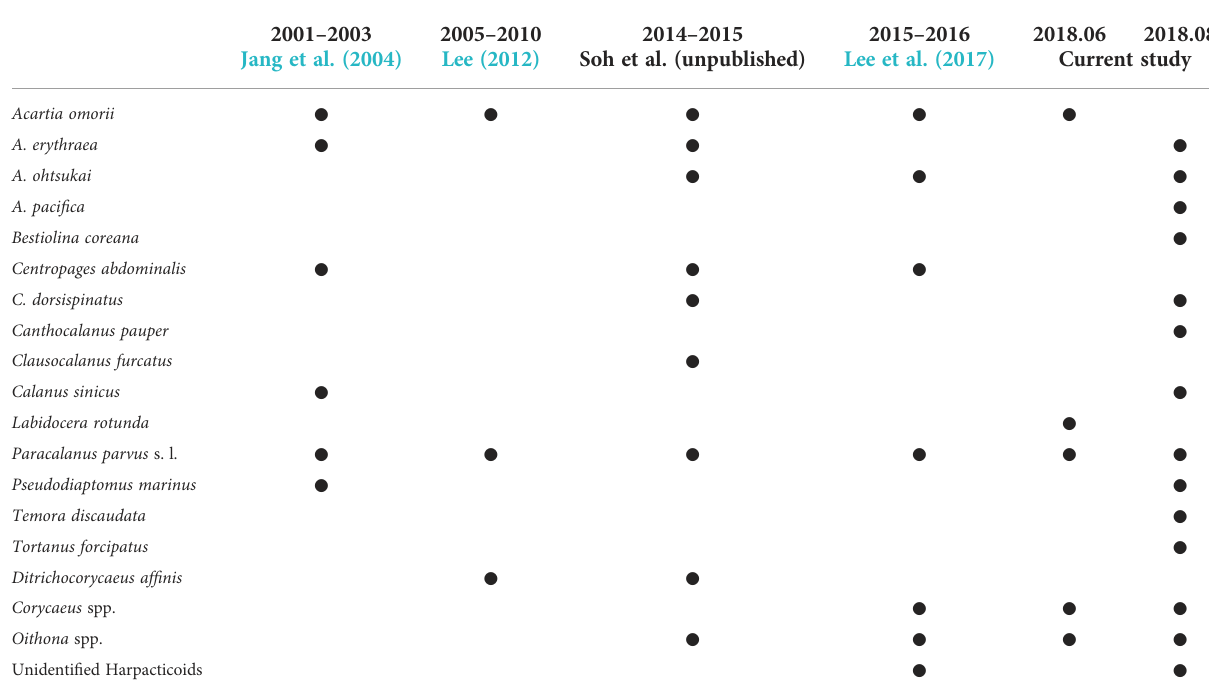
TABLE 7 Dominant copepods in Yeosu Bay from 2001 to